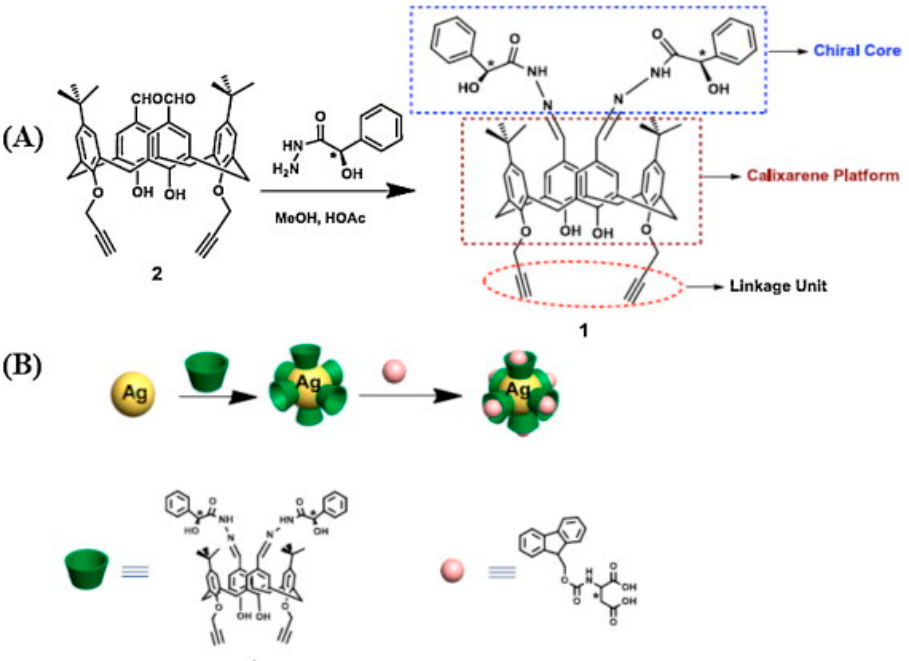
Figure 10. ( A ) Synthetic scheme of the preparation of the R -mandelic acid-functionalized calix[4]arene and ( B ) schematic representation of Ag NPs coated with the calix[4]arene derivative for detecting N -Fmoc-D / L-aspartic acid. Reprinted with permission from [93], Copyright Elsevier,